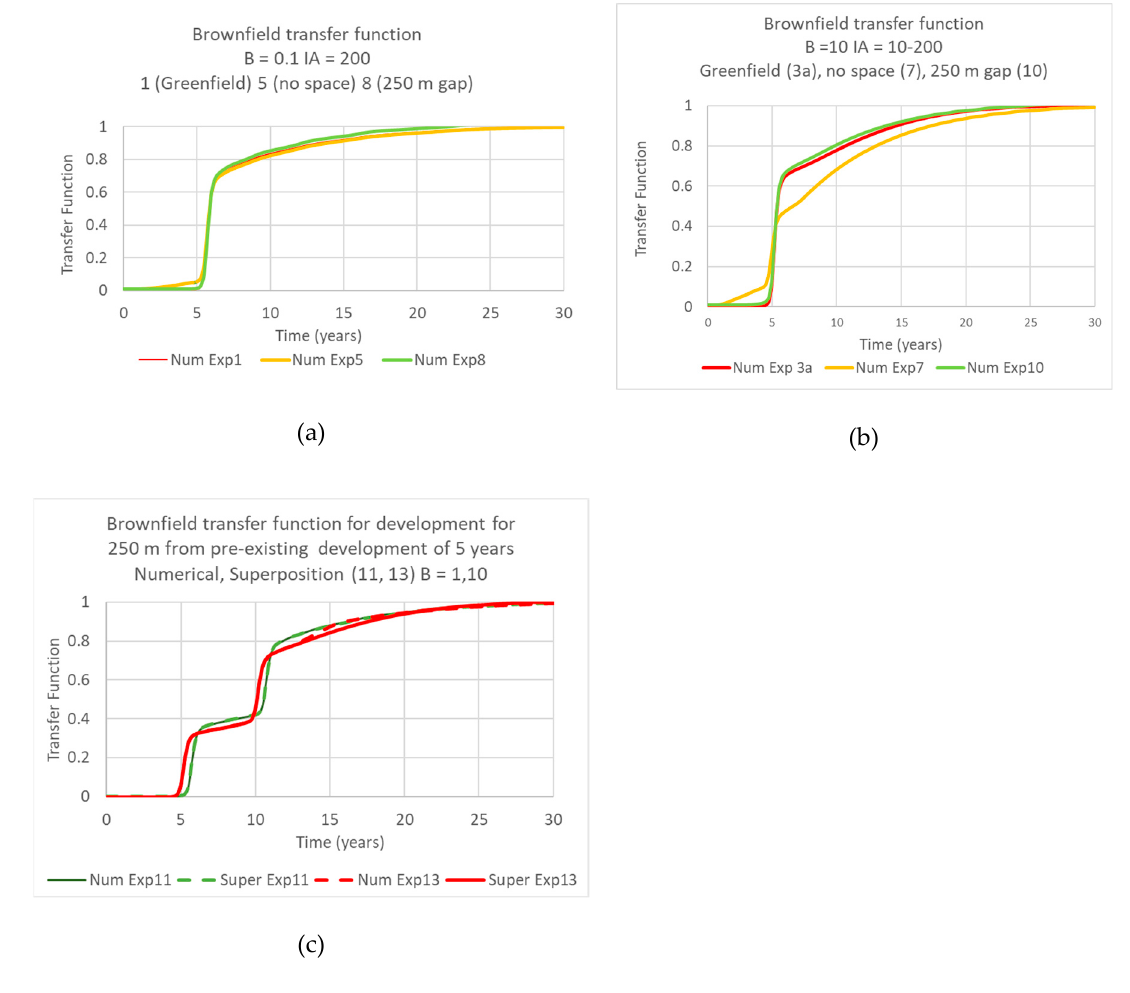
Figure 6. Functions for brownfield developments: ( a ) numerical outputs at varying distances from a pre-existing steady-state development and B = 0.1; ( b ) numerical outputs at varying distances from a pre-existing steady-state development and B = 10; ( c ) numerical outputs for the total development of a new development followed by another development, 250 m away for B = 1, 10 compared to superposition of numerical outputs for two independent developments, one 5 years after the other.